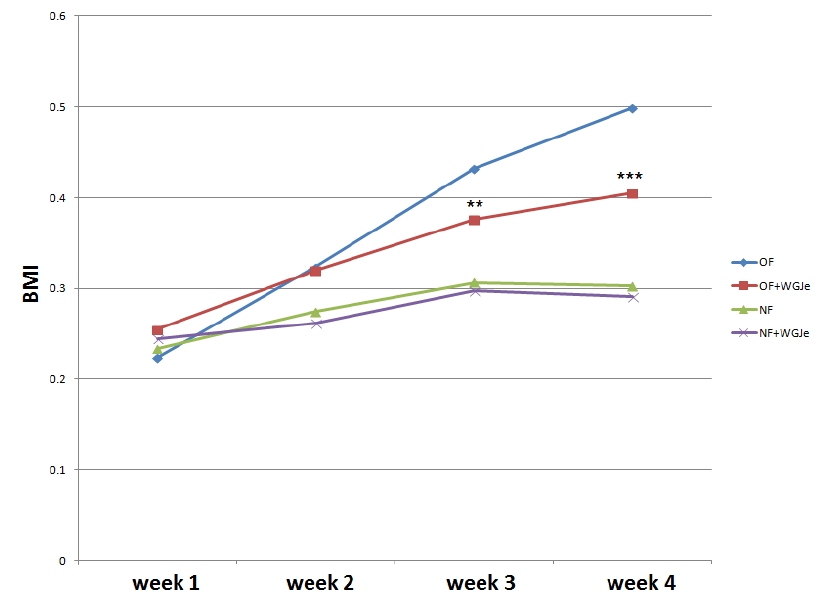
Figure 2. Effects of WGJe on body mass index (BMI) in overfed (OF) and normally fed (NF) zebrafish. The 4-week long experiment showed a constant growth of the BMI curve in OF group that decreased in the counterpart treated with WGJe. The difference between NF and NF + WGJe was not statistically significant. (** p < 0.01, *** p < 0.001, OF vs. OF + WGJe).